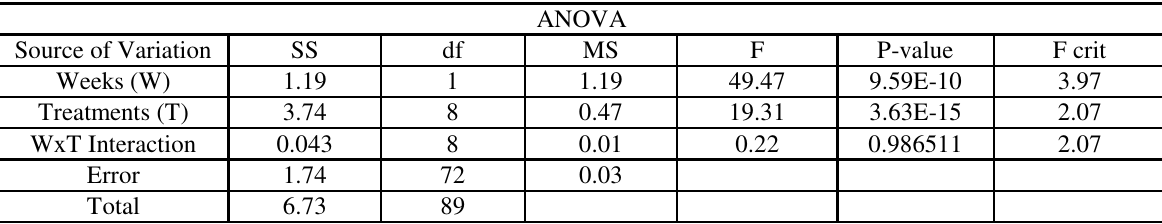
TABLE 5. TWO WAY ANOVA WITH REPLICATIONS FOR THE ALGAL BIOMASS OF BIOFILMS GROWING IN TWO DIFFERENT MEDIA WITH SELECTED PHCS